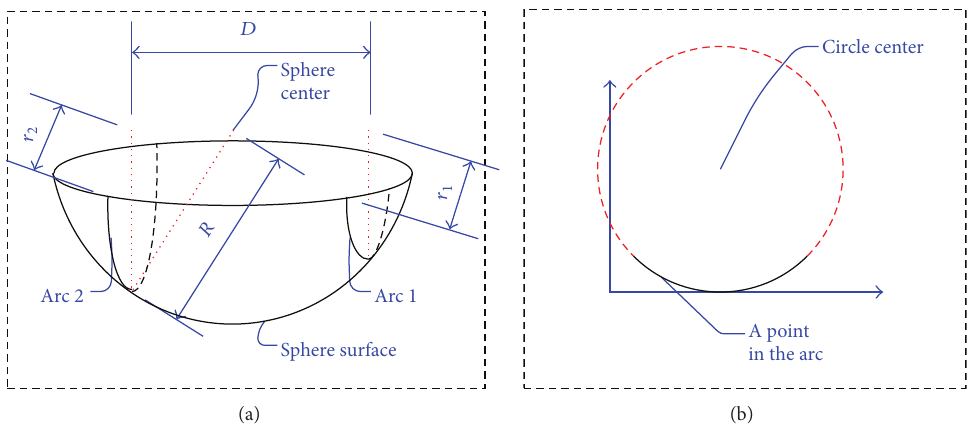
Figure 2: Measurement principle of a concave surface, where 𝐷 is distance between two parallel planes, 𝑅 is ROC of the sphere, and 𝑟 1 and 𝑟 2 are the radii of these two intersecting circles, respectively.